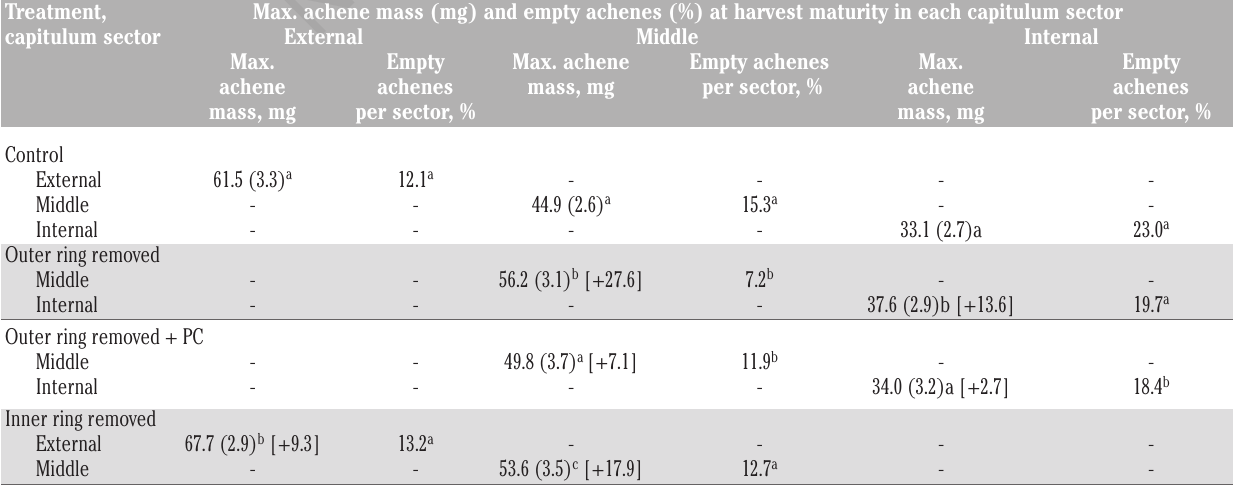
Table 2. Effect of floret removal on average dry mass per filled achene at harvest maturity and percentage of empty achenes.